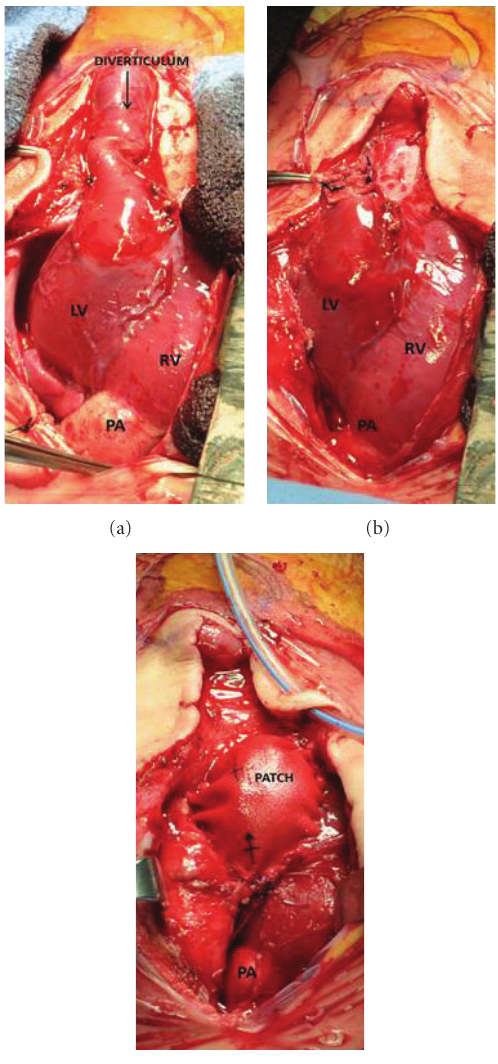
Figure 3: Thoracoabdominal incision; contracting heart while all components are shown. LV: left ventricle, RV: right ventricle, PA:pulmonary